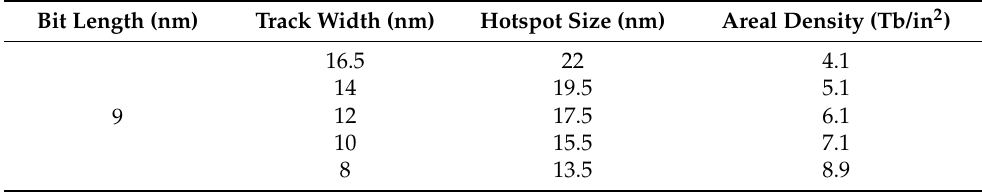
Table 2. Track width and hotspot size at ultrahigh areal density from 4.1 to 8.9 Tb/in 2 . Bit Length